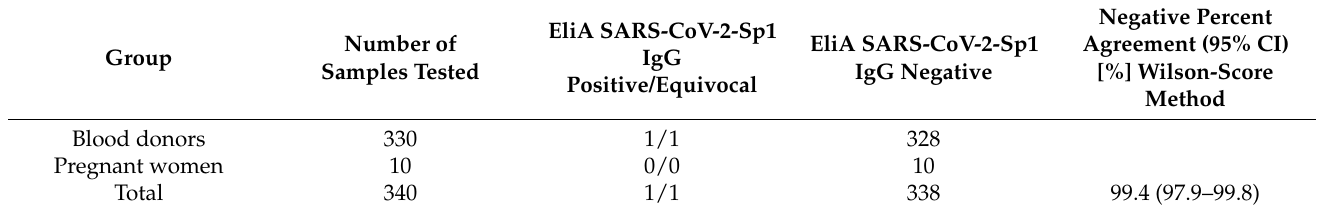
Table 2. Negative Percent Agreement (NPA).